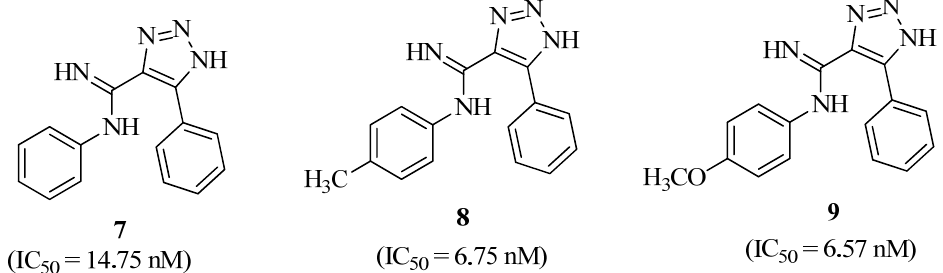
Figure 6. Benzimidazole derivative. To interact with Try629 and Lys554 at the S2 ′ position, novel uracil analogues with benzoic acid moieties at the N3 position were synthesized and tested for their DPP-IV inhibitory efficacy. From SAR studies, compound 11 was selected as the best candidate as a strong and selective DPP-IV inhibitor (IC 50 = 1.7 nM). Based on docking data, it seems that additional salt bridging between the carboxylic acid group and the primary amine group of Lys554 plays a crucial role in increasing activity. According to the findings, compound 11 (Figure 7) showed no cytotoxicity in human hepatocyte L-O2 cells at doses up to 50 μ M. Later, in vivo testing revealed that the ester of compound 11 considerably enhanced normal mice’s glucose tolerance. According to the study’s results, compound 11 has the potential to be a safe and effective medication for T2DM [34]. Figure 7. Uracil derivative containing benzoic acid as DPP-IV inhibitor.